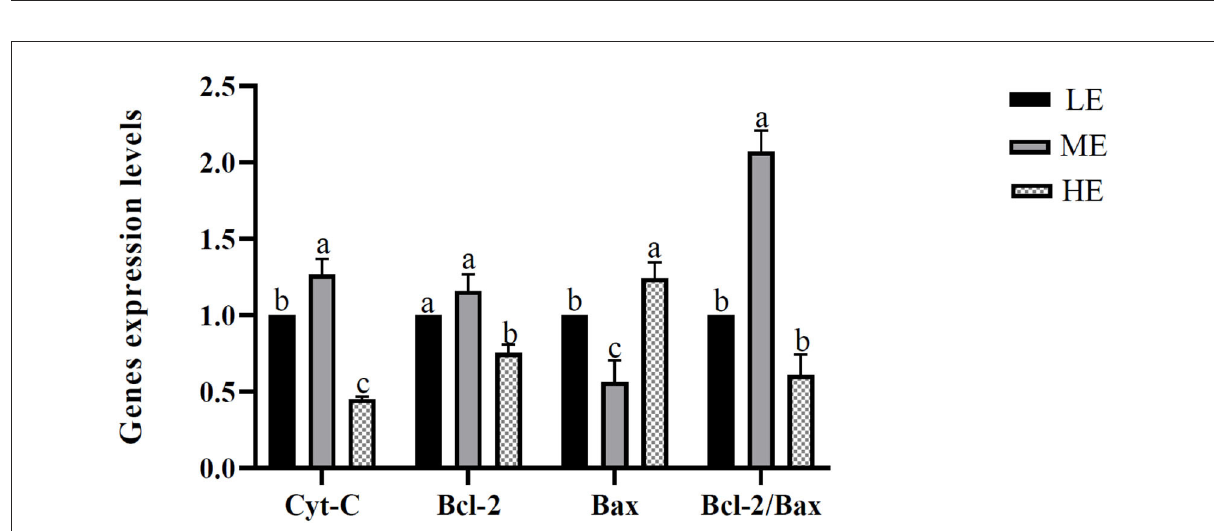
FIGURE4 Effects of differential energy treatment on the expression of mitochondria energy metabolism-related genes. LE, Low energy level; ME, Moderate energy level; HE, High energy level.